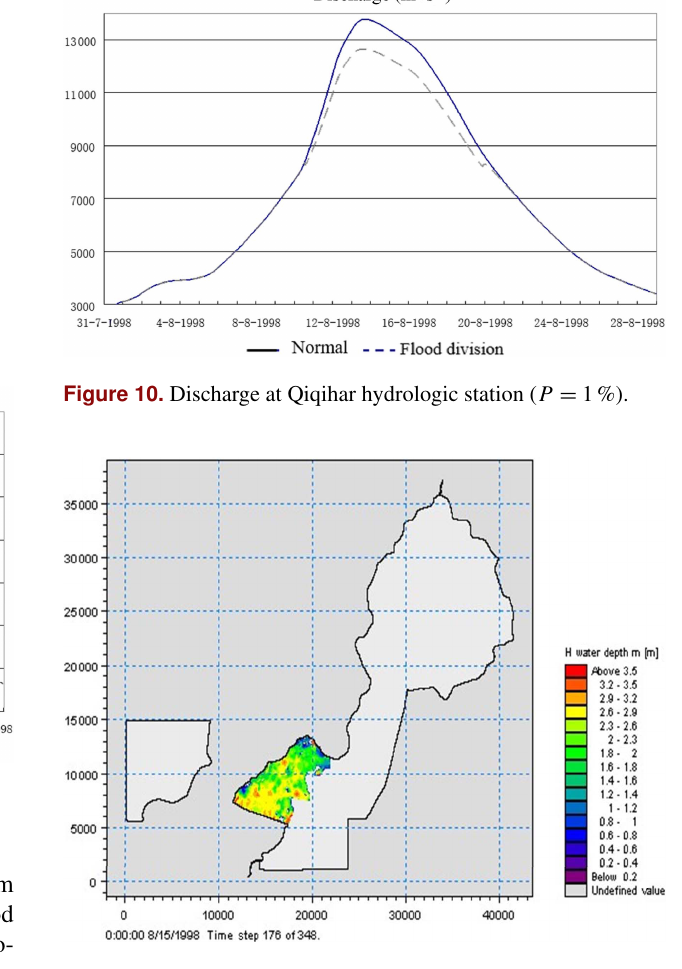
Figure 11. Submerged area in scenario